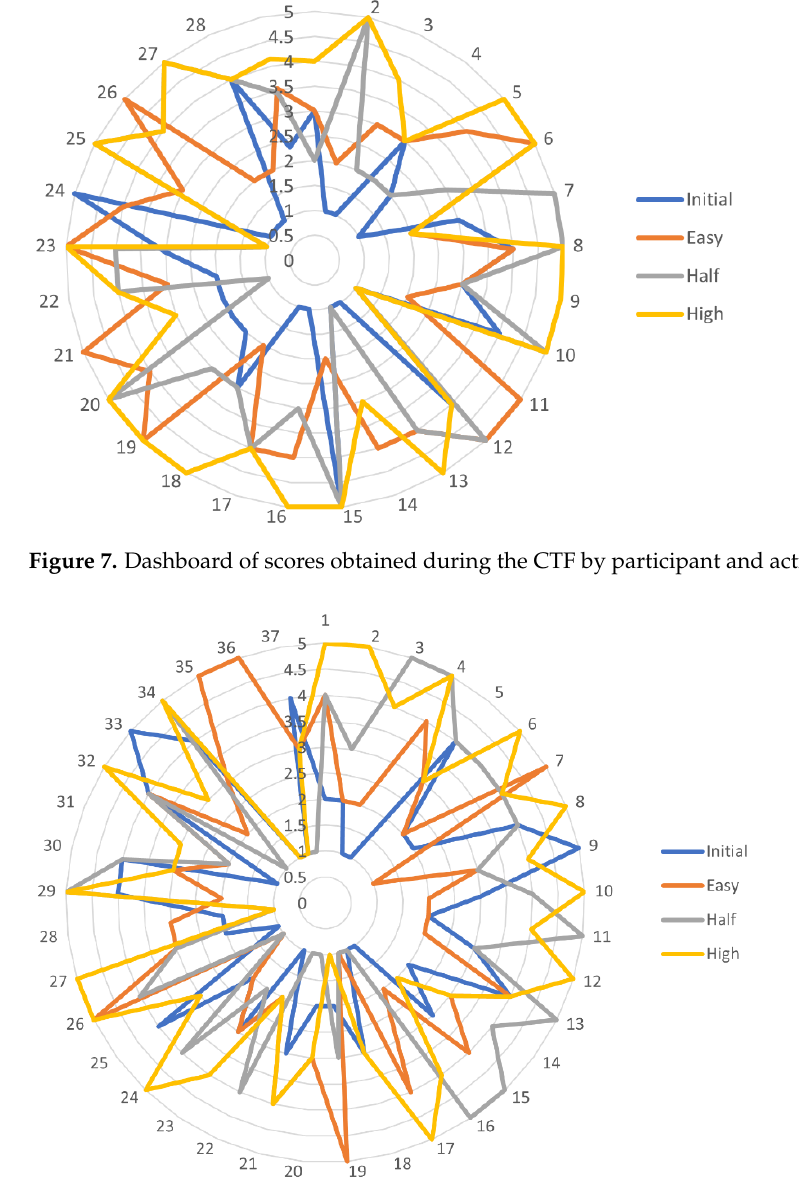
Figure 8. Dashboard of scores obtained using CTF by participant and activity in group “B”..